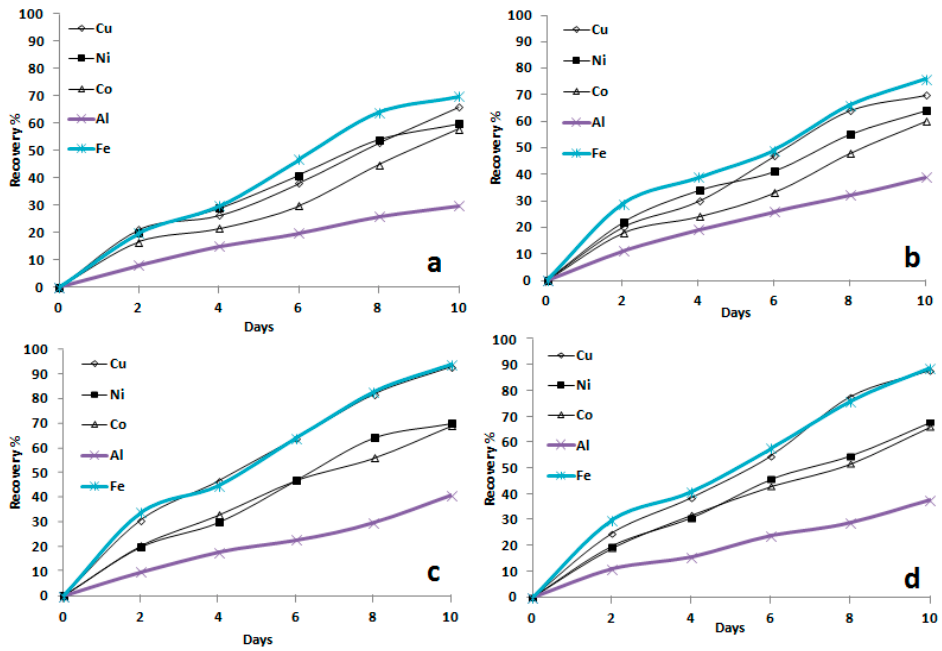
Figure 8. Metal recovery yields at various temperatures during bacterial leaching of PCB using 8% pulp density at pH 2.0 in 10 d [( a )-298 K, ( b )-303 K, ( c )-308 K, ( d )-313 K].